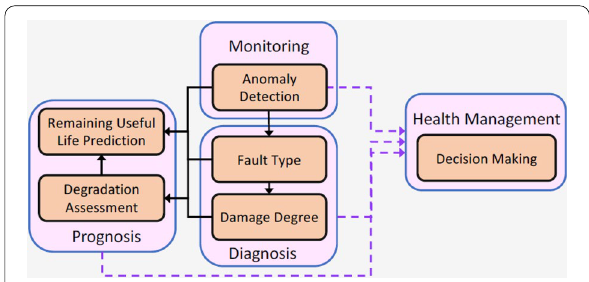
Figure 1 Relationship between monitoring, diagnosis, prognosis, and health management